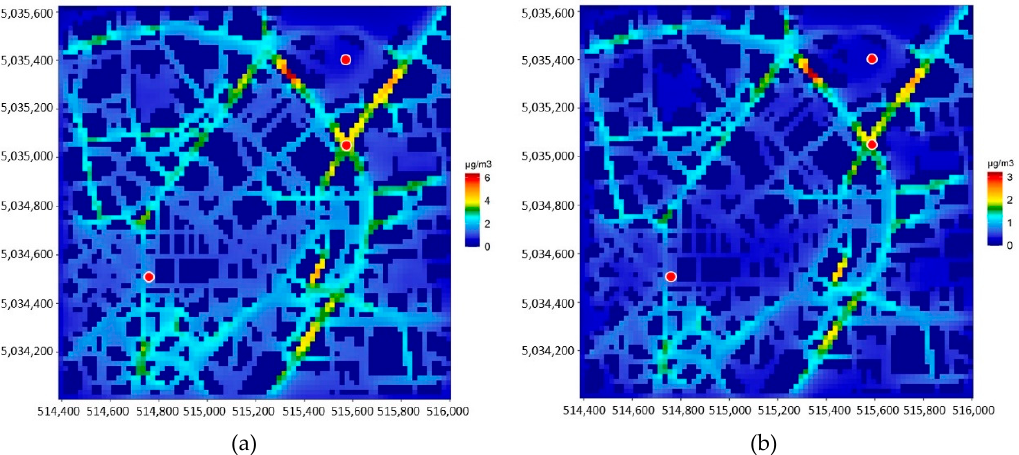
Figure 4. Spatial distribution of PM2.5 ( a ) and EC ( b ) annual mean concentrations generated by LOCAL source emissions over AUSTAL2000 computational domain .